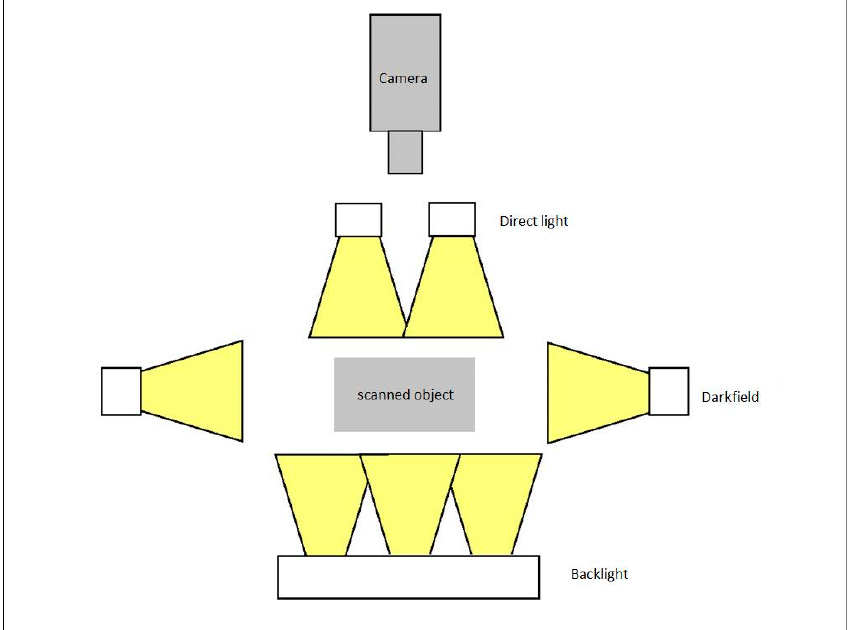
Figure 12. Possible types of lighting within the scene.